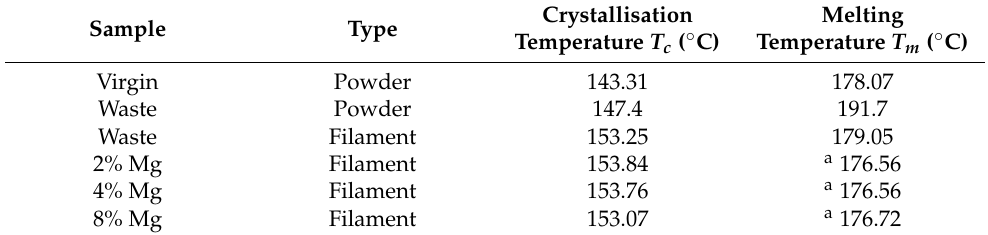
Figure 4. DSC curves for nylon and nylon–Mg composites. Table 3. Summary of DSC test